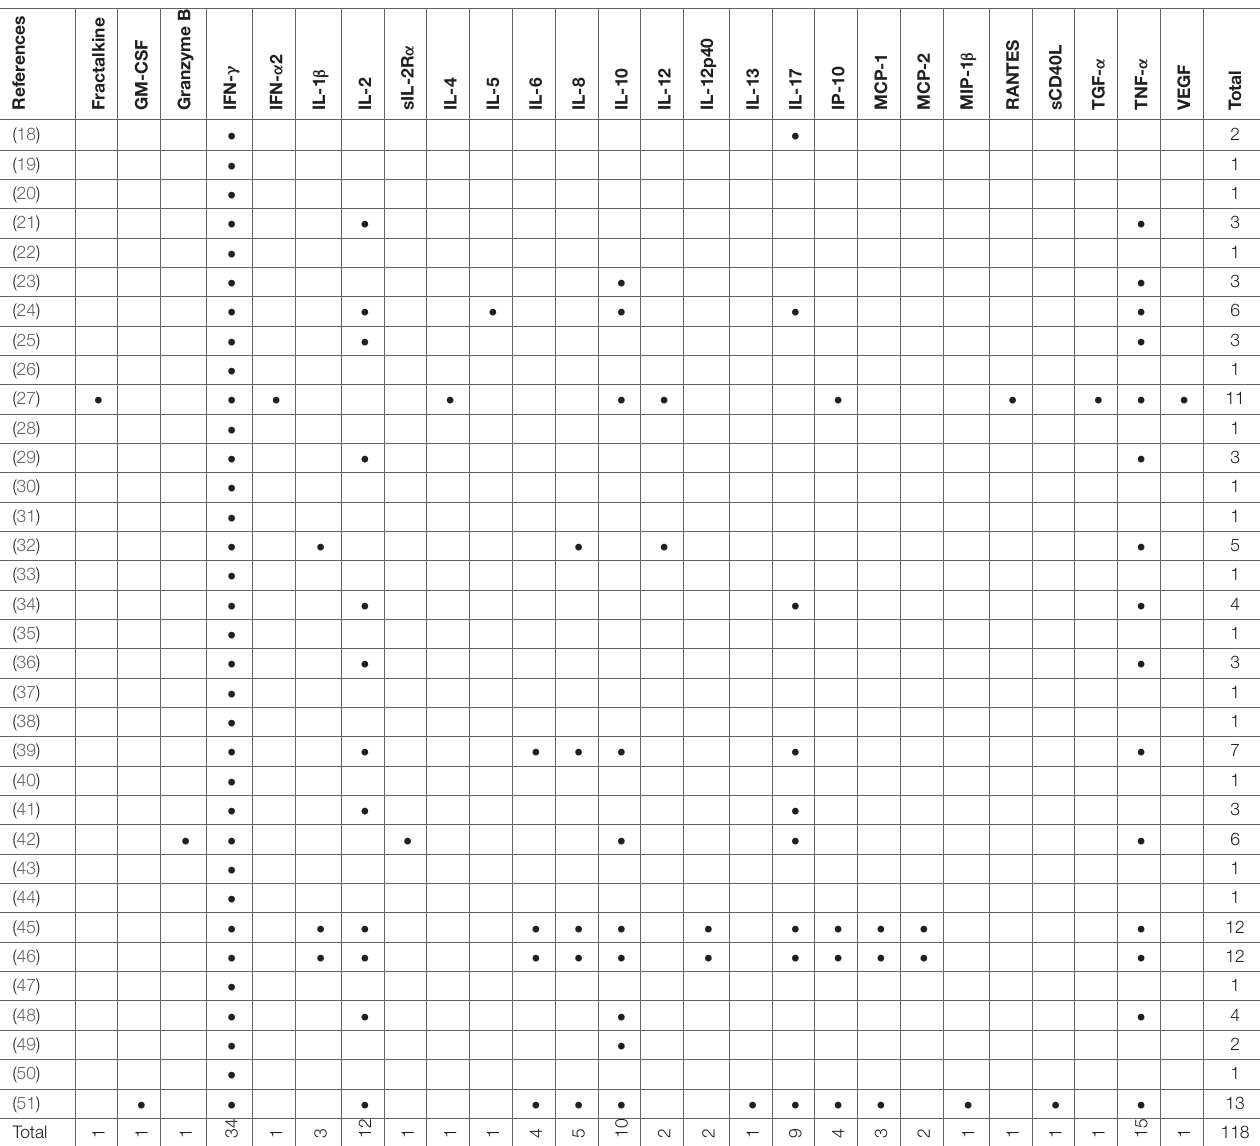
TABLE 2 | Summary of cytokines measured in studies included in this review (all cytokines